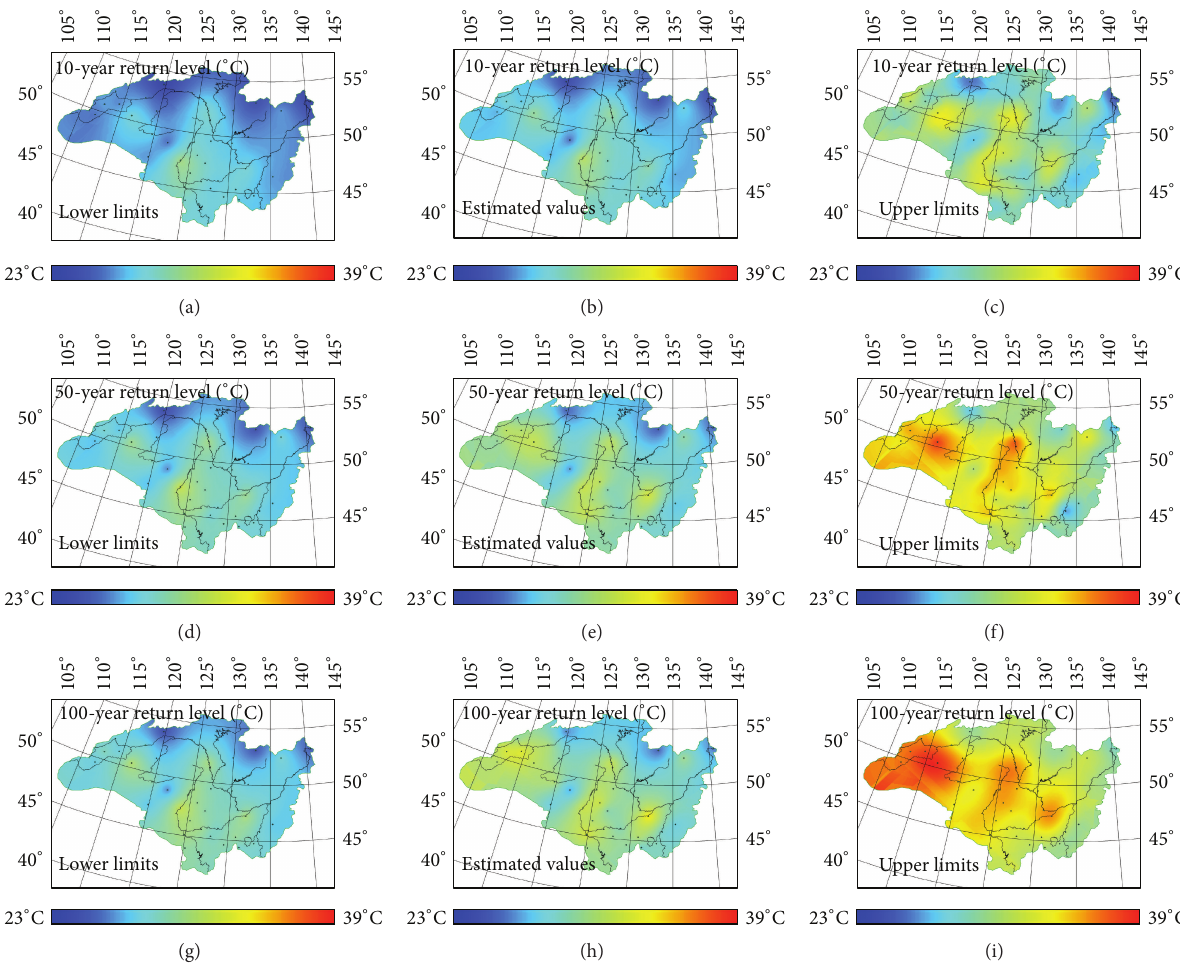
Figure 9: The spatial distribution of (a)–(c) 10-year return level, (d)–(f) 50-year return level, and (g)–(i) 100-year return level for the postchange point subseries of annual maximum temperature, respectively; meanwhile, left, middle, and right columns indicate lower limits, estimated values, and upper limits of multiyear return levels, respectively.